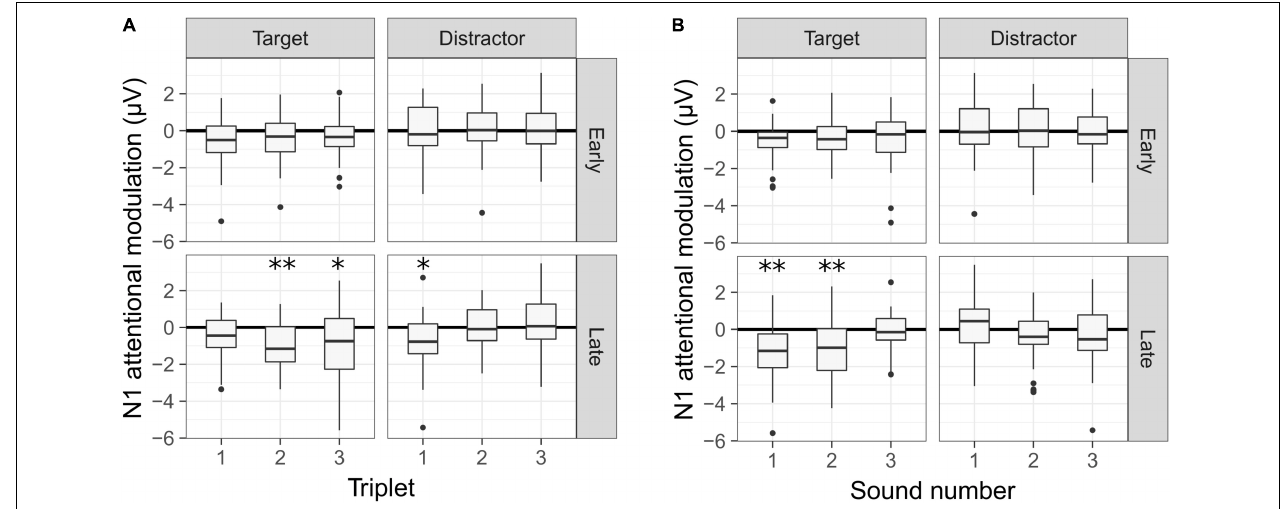
FIGURE 6 | N1 attentional modulation of the target and distractor sounds for each deviant condition. A negative value represents an enhanced N1 response in the active condition. (A) Averaged N1 attentional modulation across the three sounds of each triplet. (B) Averaged N1 attentional modulation across the three triplets for each sound. A statistically significant difference from zero is indicated by one asterisk if 0.05 > p > 0.01, two asterisks if 0.01 > p > 0.001 and three asterisks if p < 0.001. The p -values were corrected for multiple comparisons using the Bonferroni